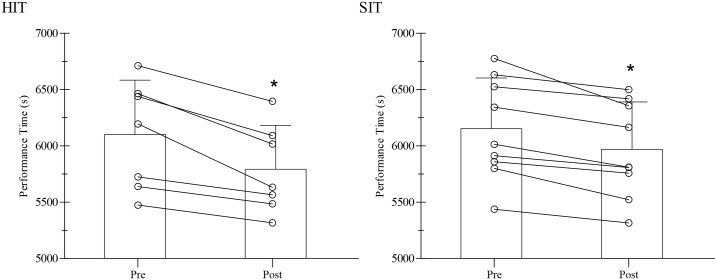
Simulation performance before (PRE) and after (POST) 6 weeks of HIT or SIT.*p<0.001 versus pre-training (main effect for time). Lines denote individual data for 7 subjects in the HIT group and 9 subjects in the SIT group. HIT—high-intensity aerobic interval training; SIT—sprint interval training.